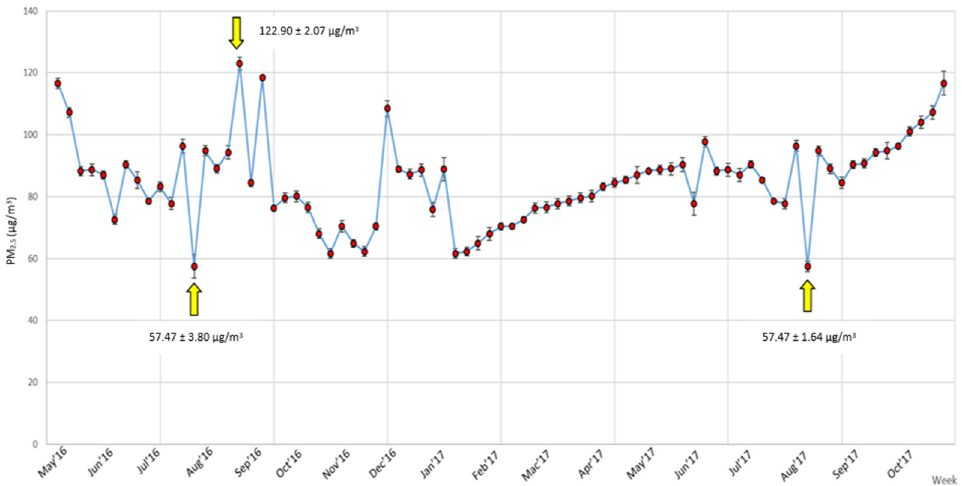
Figure 1. The PM 2.5 concentration ( µ g/m 3 ) changes in weekly basis during study period.